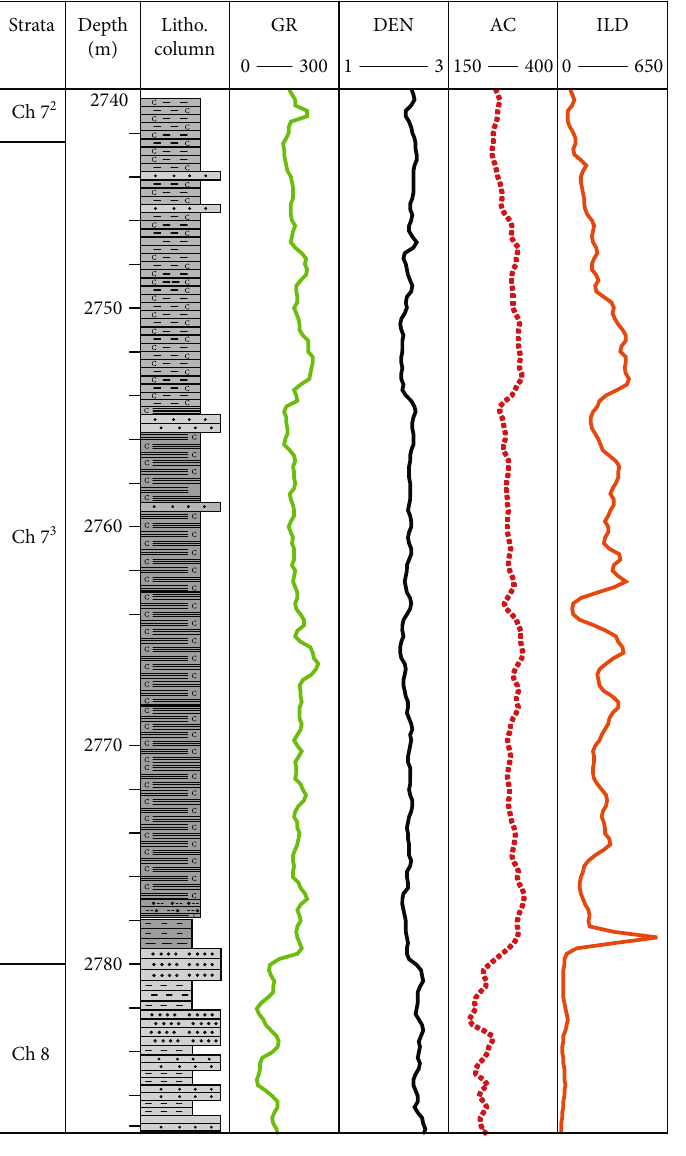
Figure 2: Logging pro fi le displaying gamma ray (GR), density (DEN), acoustic (AC), and resistivity (ILD) of Chang 7 3 sub-member from well DP1 in the western Ordos Basin. Note that the logging variations are used for stratigraphic